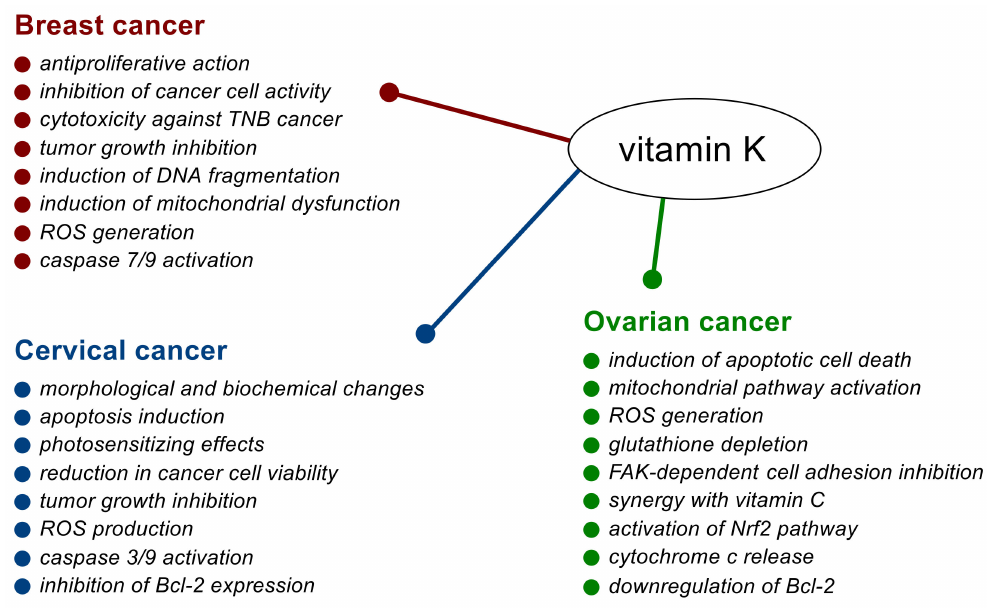
Figure 3. Effects of vitamin K on malignant neoplasms in